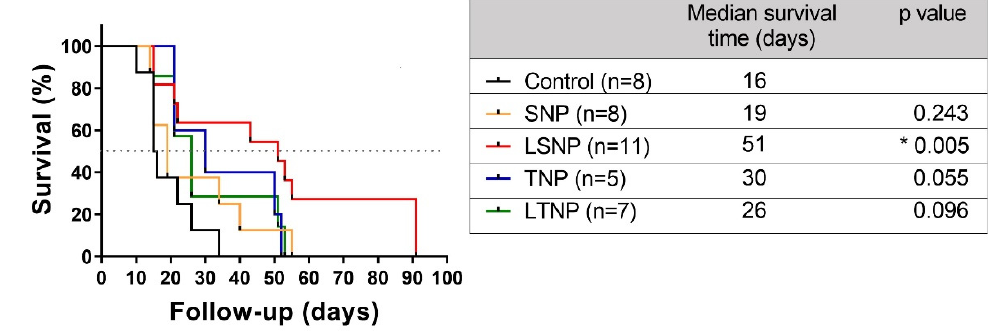
Figure 8. In situ administration of lactate-silica nanoparticles increases the median survival time in rats bearing orthotopic malignant glioma. Stereotactic implantation of 1 × 10 6 C6 cells in the right cerebral hemisphere of male Wistar rats; after 7 days they were treated with the intratumoral administration of 1 mg of nanoparticles. Survival follow-up of rats surviving the surgical procedure. Data are shown in a Kaplan–Meier survival curve (statistical analysis by log-rank test, * p = 0.005).